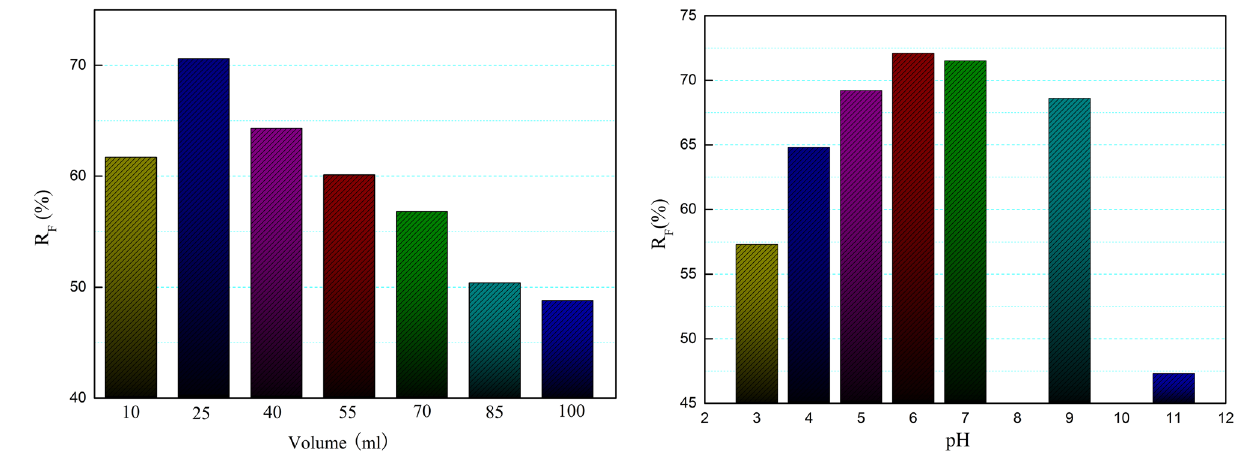
Figure 7: E ff ect of solution volume on R F . Figure 8: E ff ect of pH on R F